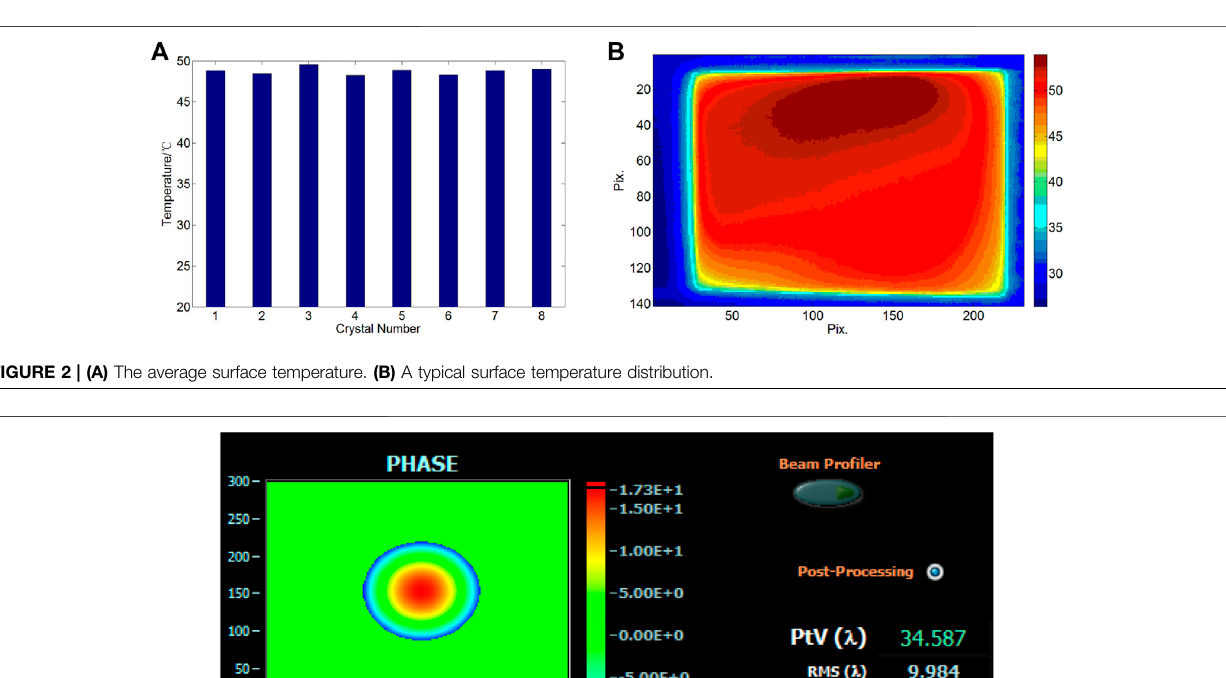
FIGURE 1 | Schematicdiagramofthe10 J – 50 Hzlasersystem.HRisthehigh-re fl ectionmirror.Pisthepolarizationmirror.Listhelens. λ /4isthe1/4waveplate.FRisthe Faraday rotator. λ /2 is the 1/2 wave plate. DM is the deformable mirror. DH is the diaphragm. WF-Detector is the wave front detector. PB is the sampling mirror with obliquity.